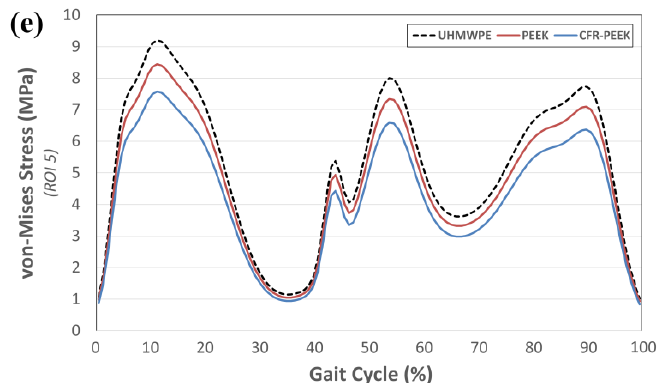
Figure 6. Comparison of von Mises stress in ROIs 1–5 with respect to different tibial bearing materials during the gait cycle: ( a ) ROI 1; ( b ) ROI 2; ( c ) ROI 3; ( d ) ROI 4; ( e ) ROI 5.